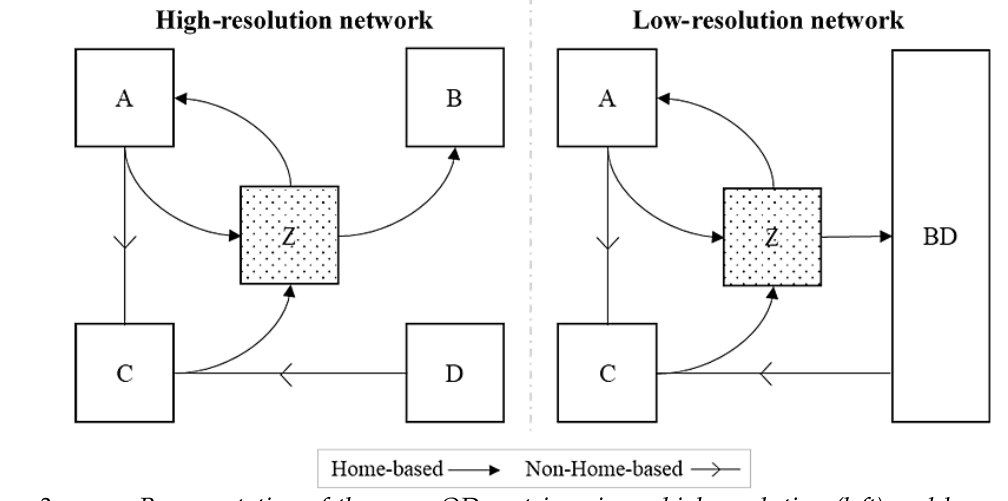
Figure 2. Representation of the same OD matrix using a high-resolution (left) and low-resolution (right) network. Effect of network density on tours’ identification